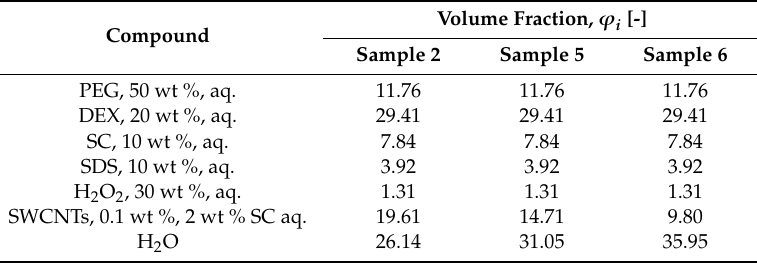
Table 2. Compositions of ATPE systems for separation of SWCNTs at a selected concentration of the H 2 O 2 modulator with varying contents of SWCNT